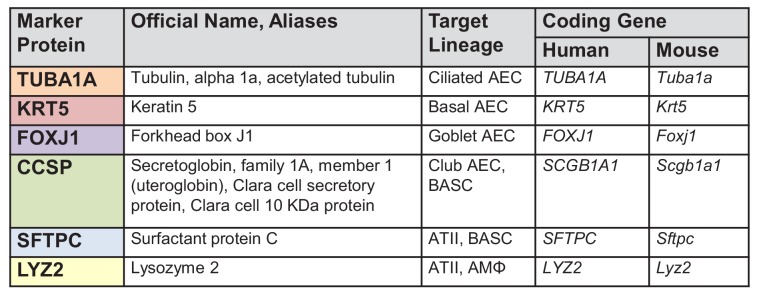
Table of pulmonary lineage markers and key abbreviations used in this study.TUBA1A, Tubulin alpha 1a or acetylated tubulin; KRT5, Keratin 5; FOXJ1, Forkhead box J1; CCSP, Secretoglobin, family 1A, member 1 (uteroglobin) or Clara cell secretory protein or Clara cell 10 KDa protein; SFTPC, Surfactant protein C; LYZ2, Lysozyme 2; AEC, airway epithelial cells; BASC, bronchoalveolar stem cells; ATII, alveolar type II cells or type II pneumocytes; AMΦ, alveolar macrophages.